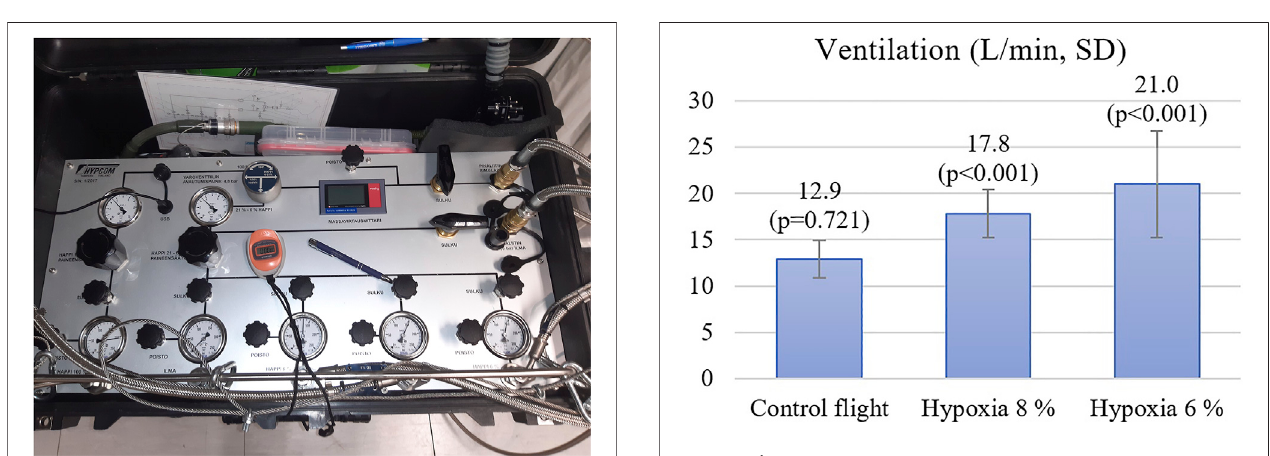
FIGURE 2 | The minute ventilation during the exposure gas (21%, 8% or